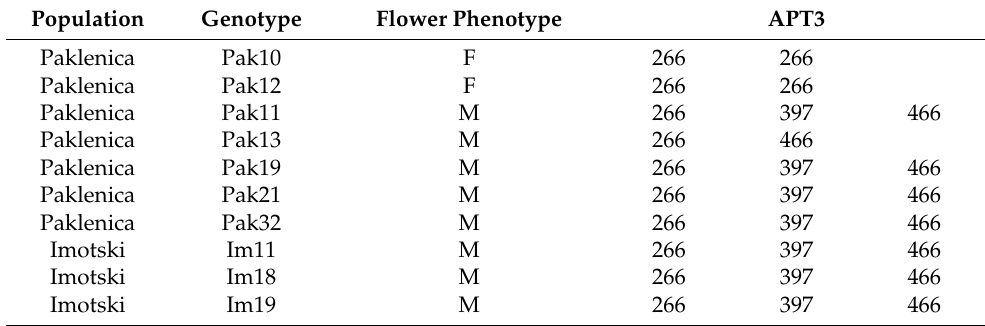
Table A1. List of V. sylvestris individuals analyzed in this study with regard to their flower mor- phology and genetics. Flower phenotype was visually determined at natural habitats, and genetic background was revealed by selective DNA marker APT3 at intron 2 on chromosome